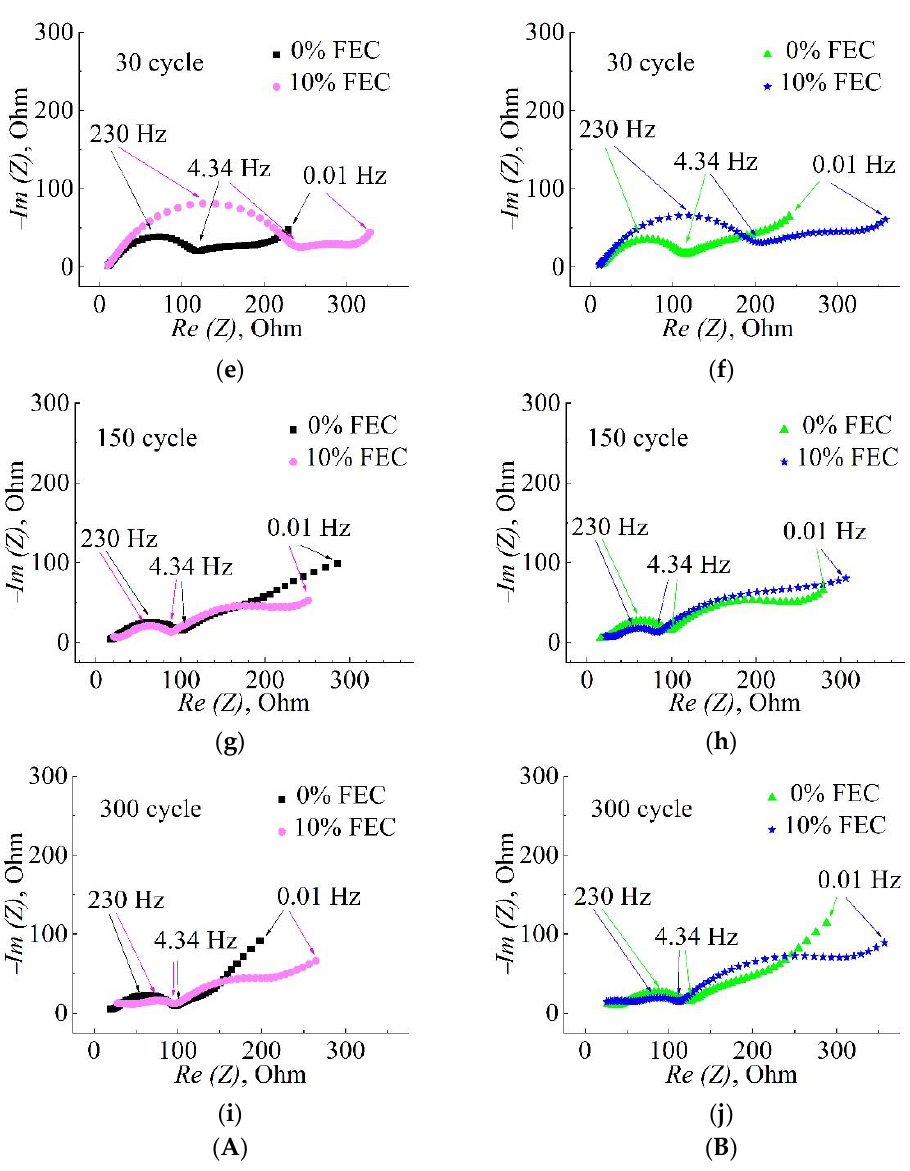
Figure 8. Transformation of the Nyquist plot shape in the process of cycling. Spectra for 3, 15, 30, 150 and 300th cycles are shown: left column for pair ( A ) ( a , c , e , g , i ); right column for pair ( B ) ( b , d , f , h , j ). Based on the spectra obtained, the following equivalent electrical circuit consisting of 5 series-connected elements was proposed (Figure 9).